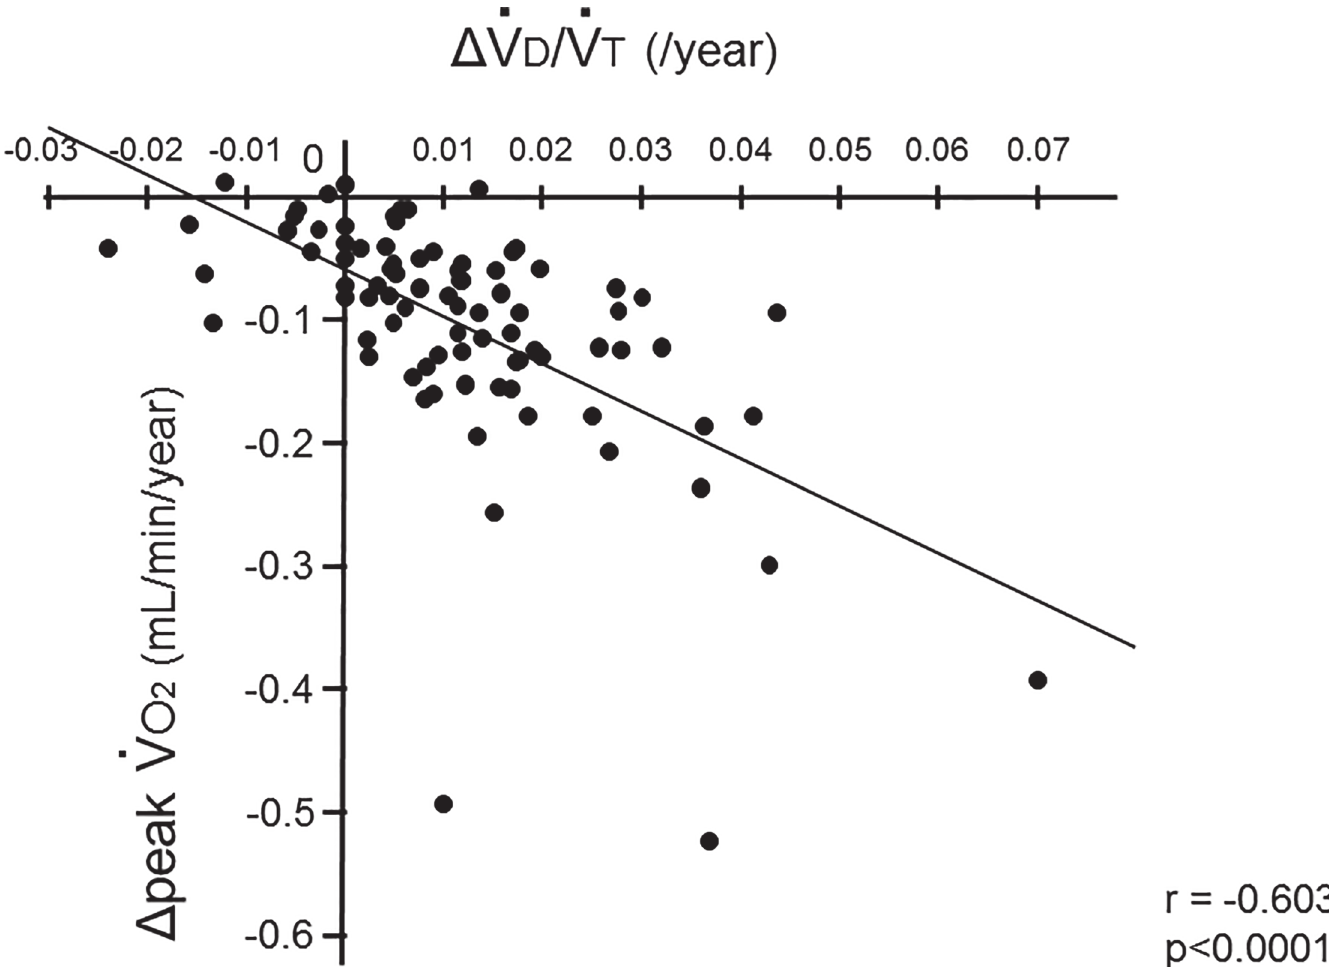
Fig 7. Relationship between the decline in aerobic capacity and the increase in dead space. The mean annual changes in peak _ V O 2 ( Δ p _ V O 2 ) were significantly correlated with those in the dead space fractions ( Δ _ V D / _ V T ) (p < 0.0001, r =